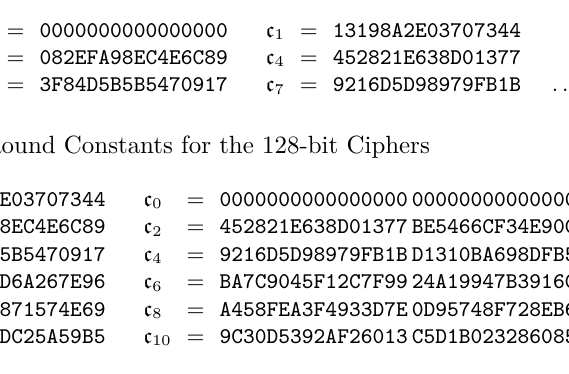
Table 1: The Round Constants for the 64-bit Ciphers